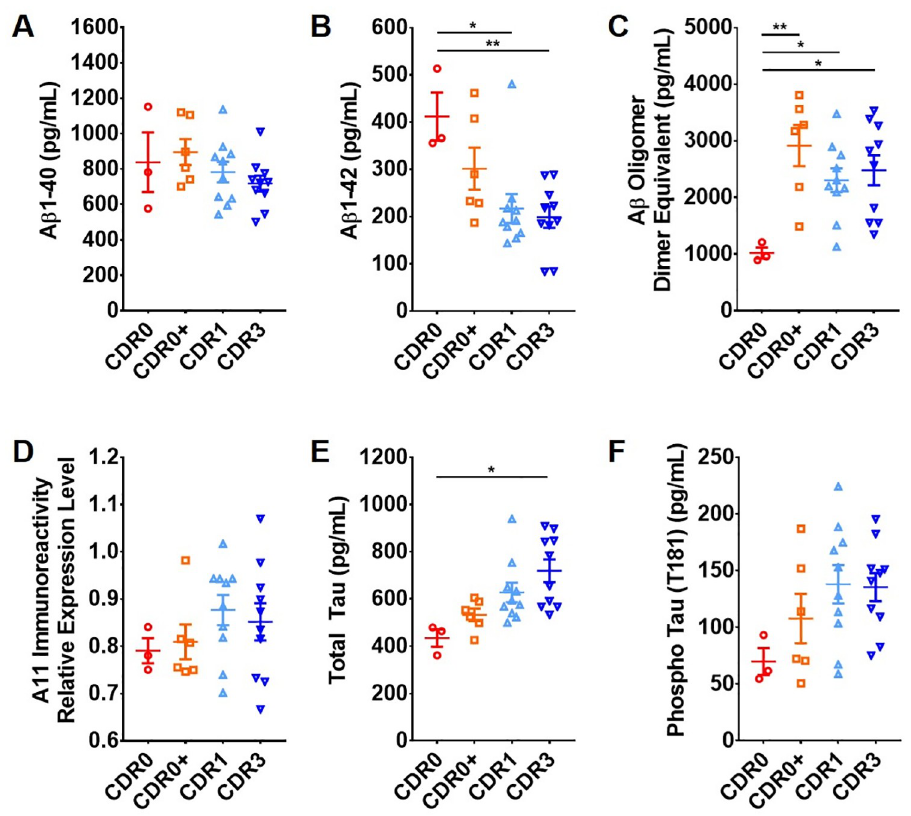
Fig 2. Scatterplots of individual levels of A β and tau in brain homogenates from control and AD cases. All samples were measured in triplicate. One-way ANOVA followed by Tukey’s multiple comparisons test were used for all measurements ( ��� p � 0.001, �� p � 0.01, � p � 0.05, error bar indicates SEM). (A) The levels of A β 1–40 did not differ among sample groups; (B) The level of A β 1–42 in the CDR0 group was significantly higher in than in the CDR1 group ( p = 0.016) and CDR3 group ( p = 0.0078); (C) The level of A β oligomer measured by sandwich ELISA in CDR0 group was significantly lower than CDR0+ ( p = 0.0021), CDR1 ( p = 0.0352), and CDR3 ( p = 0.0156) groups; (D) The levels of A11 positive oligomer measured by indirect ELISA did not significantly differ between groups; (E) The level of total tau was significantly lower in the CDR0 group than in the CDR3 group ( p = 0.0101); (F) The levels of T181 phosphorylated tau did not significantly differ between